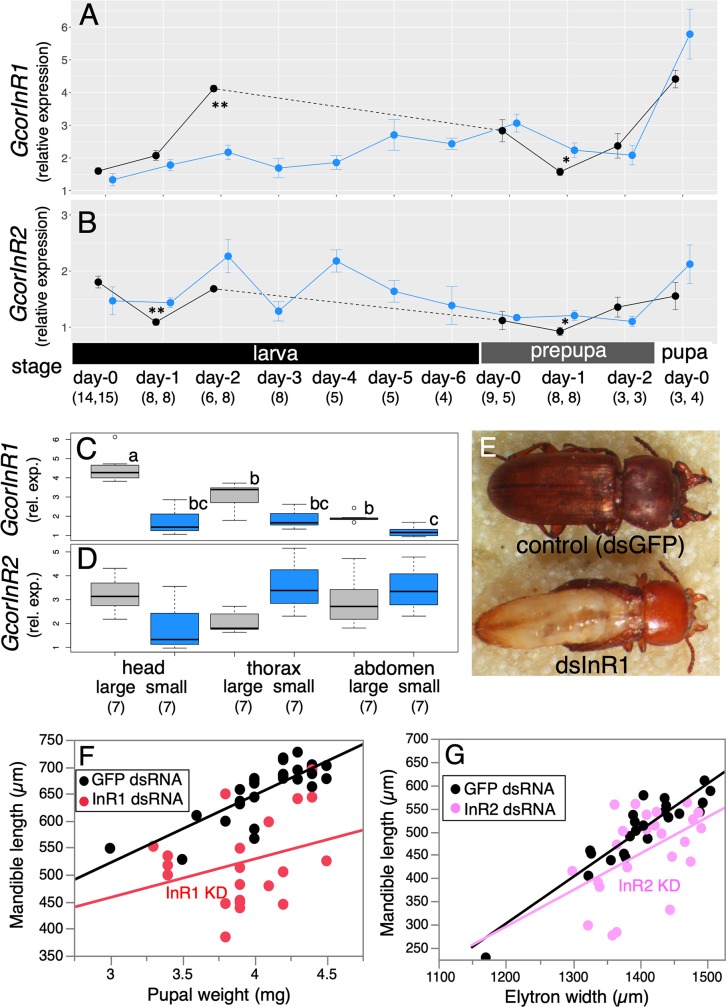
Functional analysis of insulin-like receptors.(A,B) GcorInR1 and GcorInR2 developmental dynamics, black: large larvae, blue: small larvae. Results are presented as mean ± SE. Asterisks show significant differences between large and small larvae of the same stages (Mann-Whitney U test, *p < 0.05, **p < 0.01, ***p < 0.001). See Fig 3 caption for abbreviations day-0, -1, etc. (C,D) Body-part specificities of GcorInR1 and GcorInR2. Different letters indicate significant differences (Steel-Dwass test). Gray: large, blue: small. Day-2 larvae were subjected to analysis. Gene expression levels relative to Gcorgapdh were quantified by qPCR. (E) GcorInR1RNAi individuals suffered from severe systemic defects characterized by the malformation of fore- and hind wings, even under the weakest KD (28% reduction, S1 Table). (F) Mandible lengths were plotted against pupal weights for teratogenic GcorInR1RNAi males and normal dsGFP males (n = 21 and 29, respectively). (G) GcorInR2RNAi males exhibited smaller mandible size without teratogenesis (n = 24 each) under intermediate level of KD (36% reduction, S1 Table). The underlying data in this figure are available from figshare (DOI: 10.6084/m9.figshare.9734780; https://figshare.com/s/609486022a3df39169bf). dsGFP, double-stranded RNA for GFP; dsRNA, double-stranded RNA; Gcorgapdh, G. cornutus glyceraldehyde 3-phosphate dehydrogenase; GcorInR, G. cornutus InR; GFP, green fluorescent protein; InR, insulin-like receptor; KD, knockdown; qPCR, quantitative PCR; rel. exp., relative expression; RNAi, RNA interference.